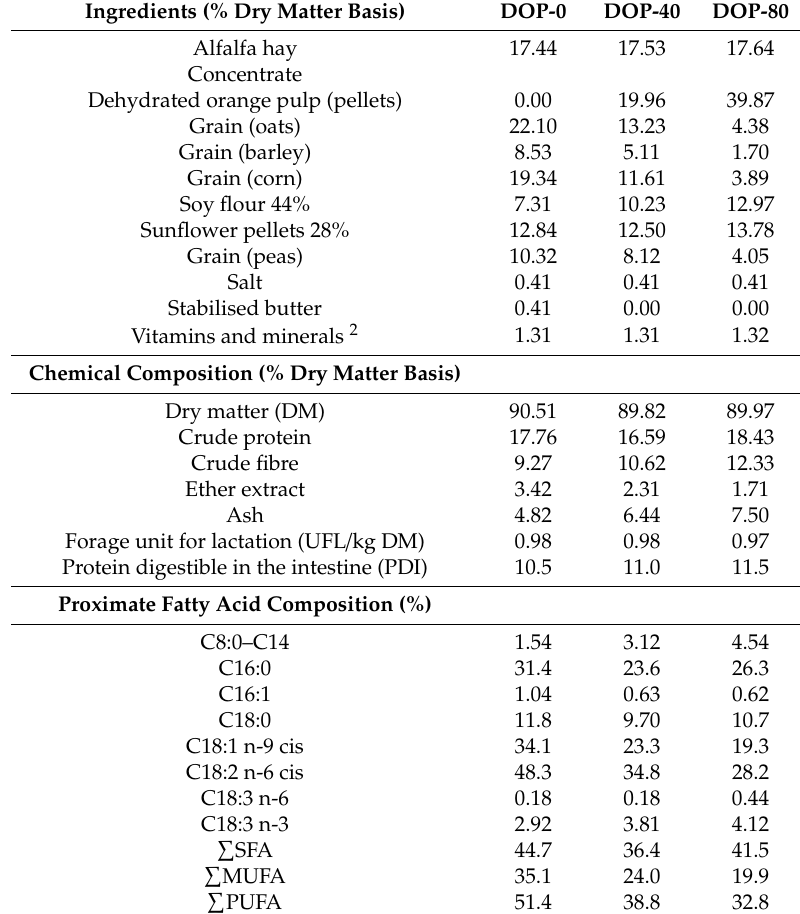
Table 1. Ingredients, chemical composition, nutritive value, and proximate fatty acid (FA) composition of the experimental diets 1 used to feed the Payoya